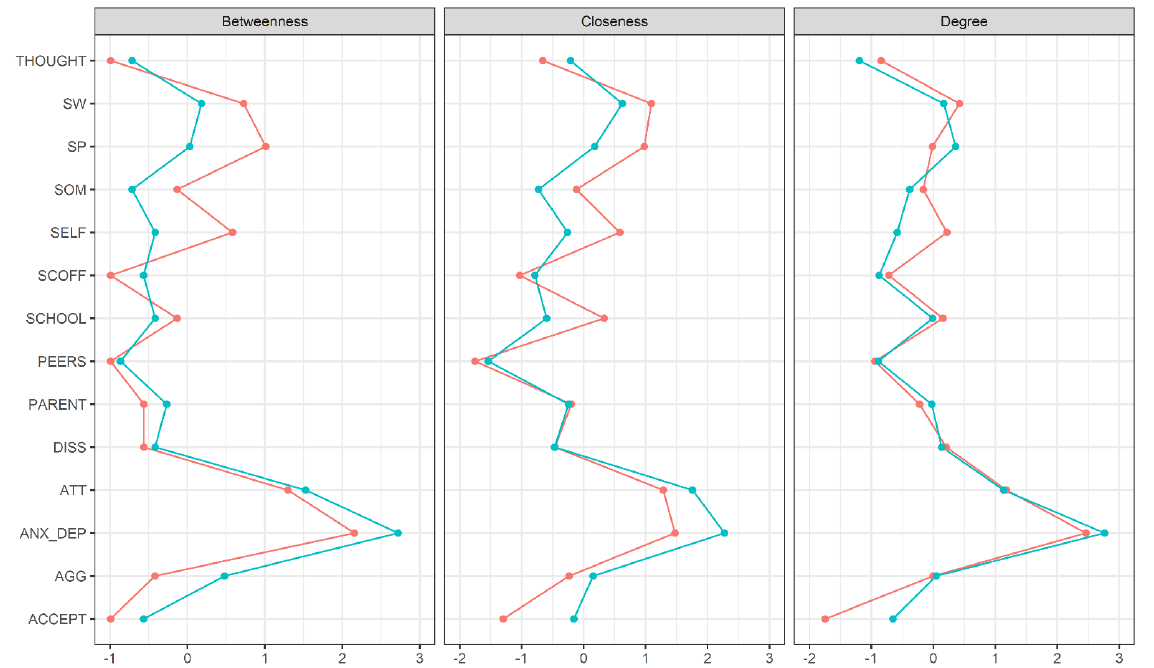
Figure 2. Centrality plot depicting standardized centrality indices (betweenness, closeness, degree = strength) of psy- chopathological symptoms, eating disorder risk and well-being measures in overweight (blue lines) and underweight (red lines) adolescents. See footnote of Figure 1 for variable abbreviations.